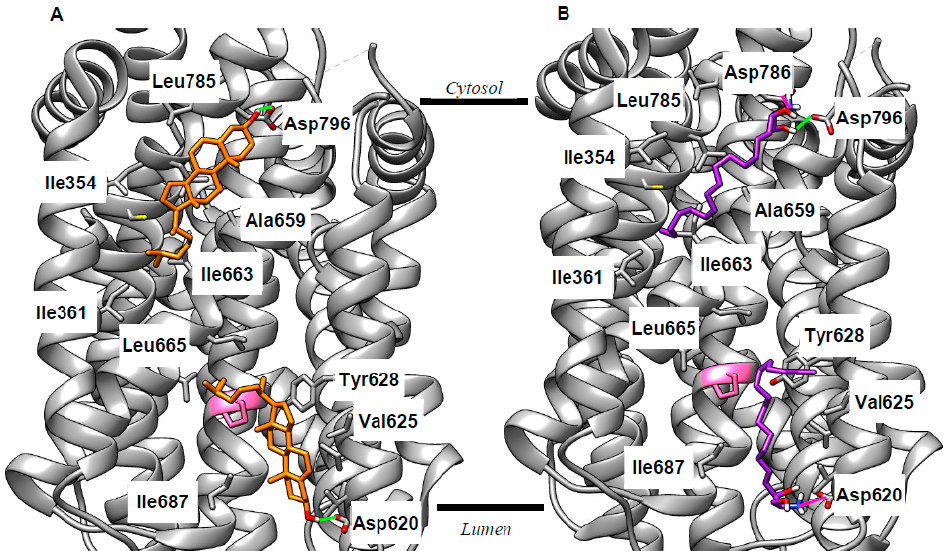
Figure 3. Docking identifies two putative binding pockets on NPC1 aligned to each side of the lysosomal membrane. Sample poses for both cholesterol (orange, A ) and sphingosine (purple, B ) show binding in these pockets consistent with evidence of NPC1’s role as an exporter of both lipids. Selected interacting residues are labeled; H-bonds are shown in green (Sph and cholesterol), and ionic interactions are shown in magenta (Sph only). Pro691 is shown in pink; mutation of this residue results in reduced cholesterol binding [53,54]. Lines indicate the approximate position of the membrane (derived from the Orientation of Proteins in Membranes OPM database [51]).